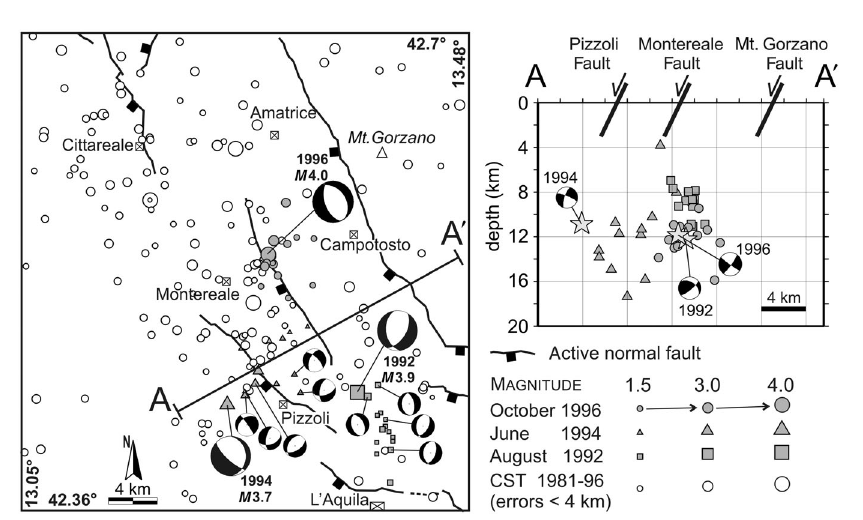
Fig. 4. Epicentral distribution of the best-located events of the 1996 sequence (present study) 1992 and 1994 sequences (from De Luca et al. , 2000) and 1981-1996 seismicity from the CST catalogue (ING-GNDT, 2001; A and B quality, depth errors < 4 km). Along the A-A ′ section, all the hypocentres of the 1992, 1994, and 1996 sequences and the focal mechanisms of the related main shocks are